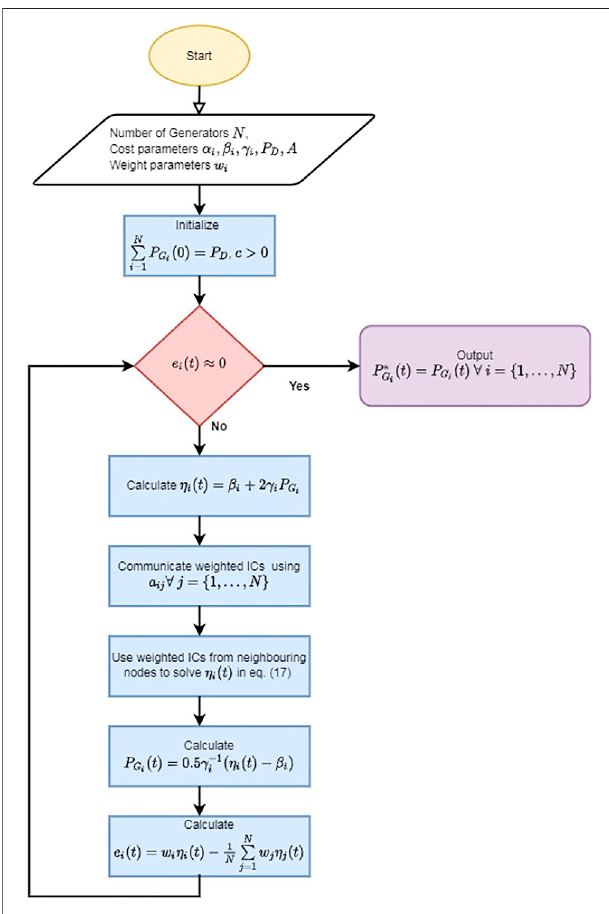
FIGURE 1 | Flow chart of weighted IC consensus